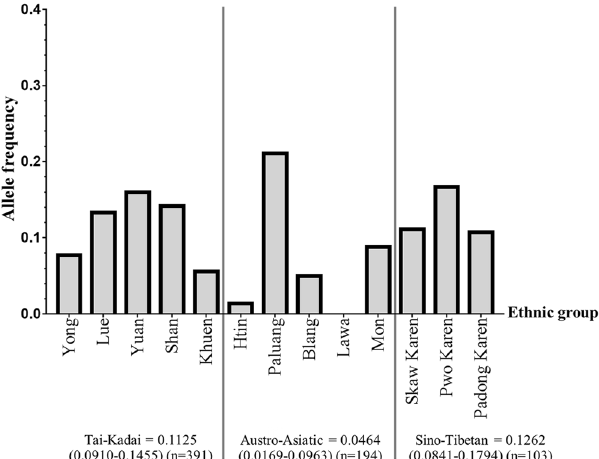
Figure 2. The allele frequency of common α -thalassaemia in each ethnic group. The bar graph represents α -thalassa emia allele frequency. At the bottom of the figure, the total allele frequency of common α -thalassaemia is shown regarding the analysis of the three linguistic groups (Tai-Kadai, Austro-Asiatic and Sino-Tibetan).